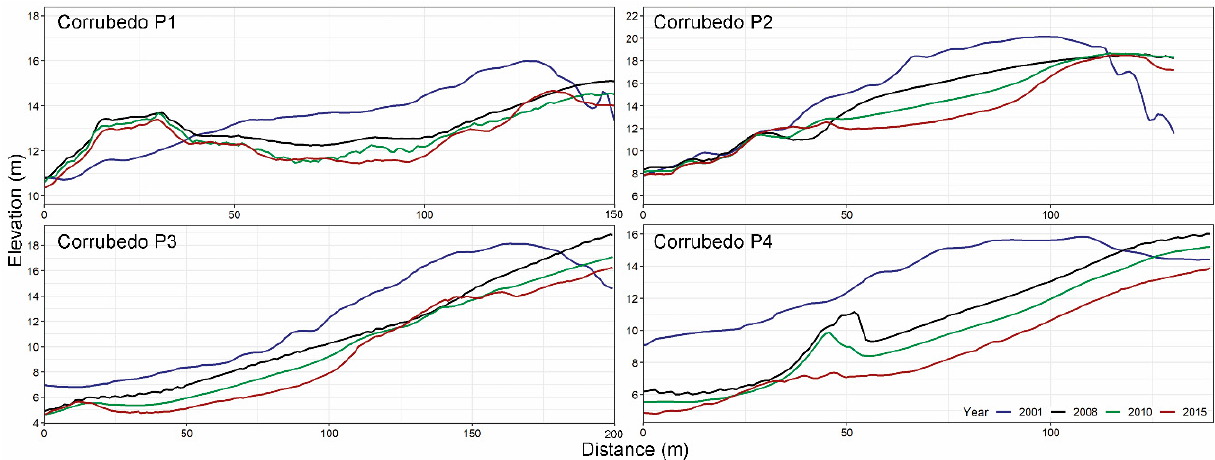
Figure 8. Topographic profiles in the crest of dune mobile sector between 2001 and 2015. The position of these profiles appears in Figure 1c in red color.